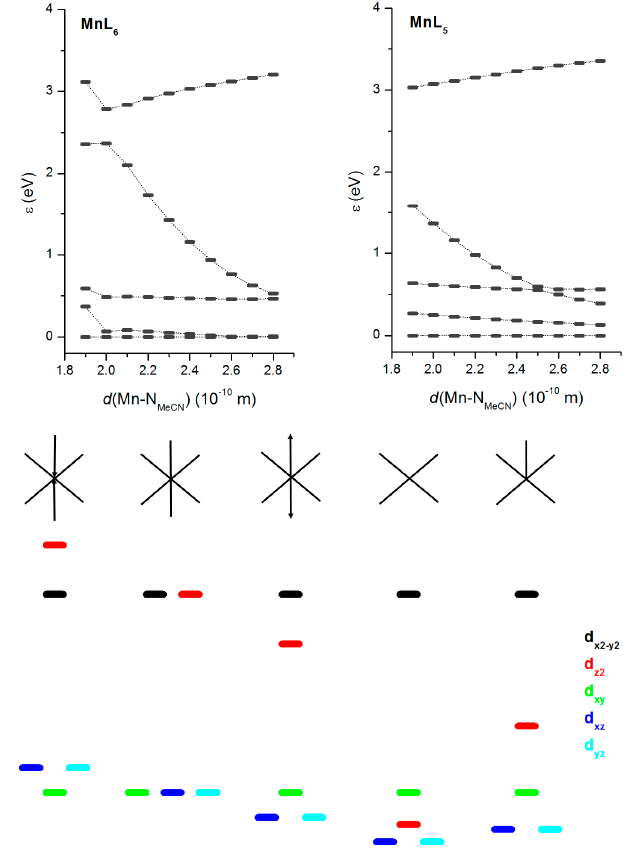
Figure 4. Top : the calculated d -orbitals energy splitting for the model compounds [Mn(L4A)(MeCN)] + (MnL 6 ) and [Mn(L4A)(MeCN) 2 ] + (MnL 5 ) for varying Mn–N MeCN distance(s) from 1.9–2.8 Å using B3LYP/ZORA/def2-TZVP(-f); Bottom : variation of d -orbitals energy according to the crystal-field theory for idealized geometries (compressed square-bipyramid, octahedral, elongated square-bipyramid, square-planar, and square-pyramidal).